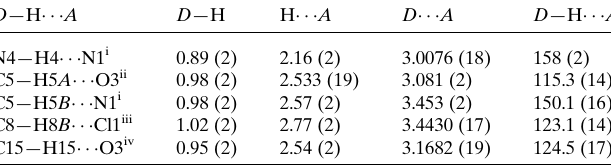
Table 2 Summary of short interatomic contacts (A˚ ) in the title compound.